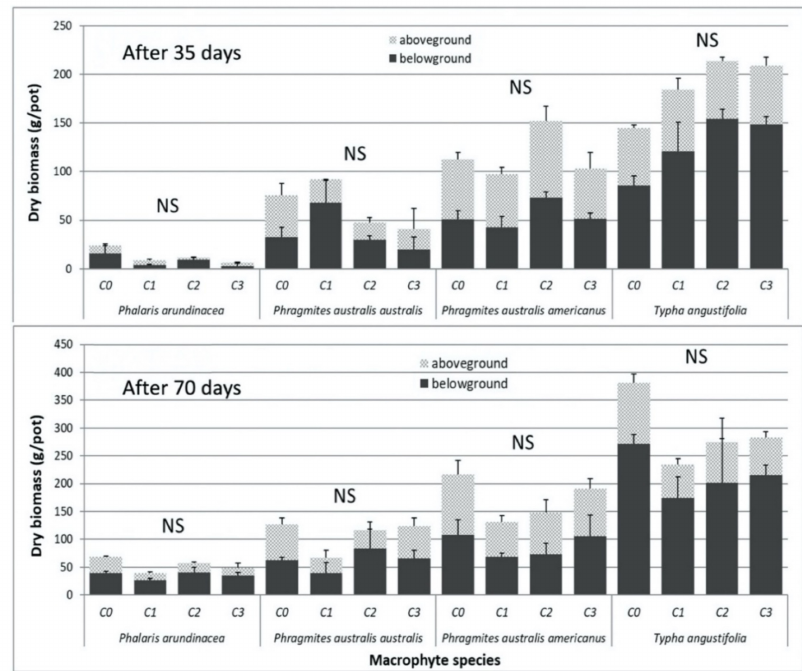
Figure 1. Mean (with standard error) above- and belowground dry biomass (g / pot) of the four macrophyte species exposed to four contaminant concentrations ( C0–C3 ) in the leachates after 35 and 70 days. ( NS ) No significant di ff erence between mean values across the treatments for a given sampling date of a plant species, for either total biomass or aboveground and belowground biomass considered alone, according to Tukey’s test, α < 0.05.